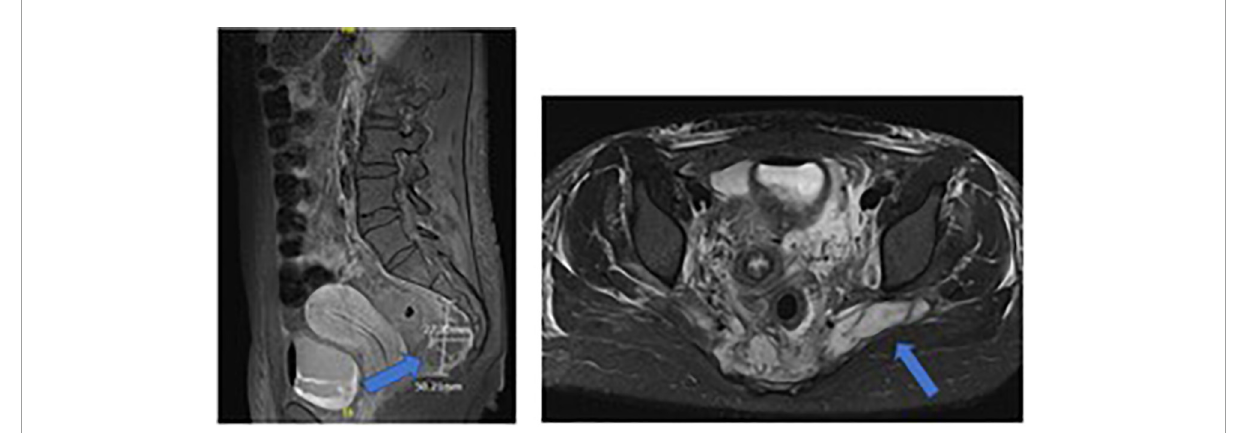
FIGURE3 Sacral MRI of case 3: sacral osteomyelitis and multiple adjacent